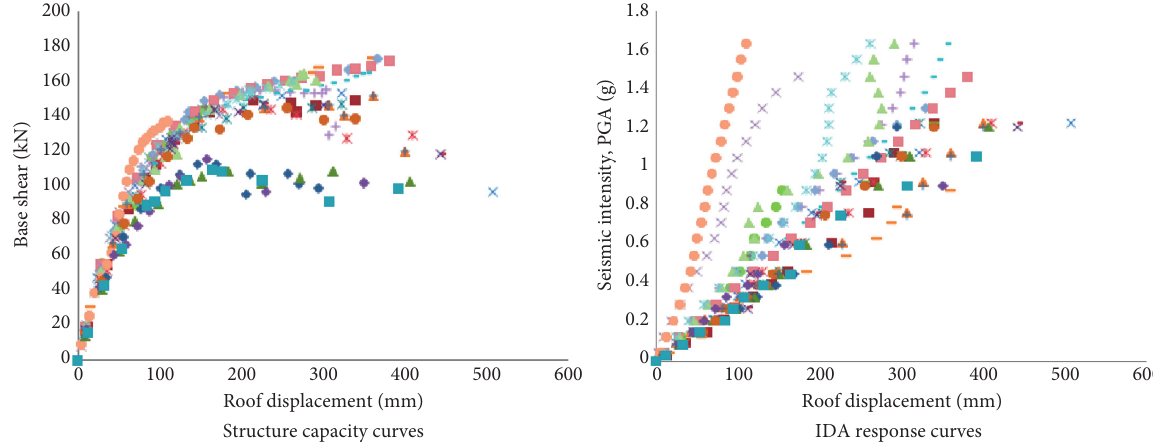
Figure 15: Structural response curves based on IDA technique for the frame building